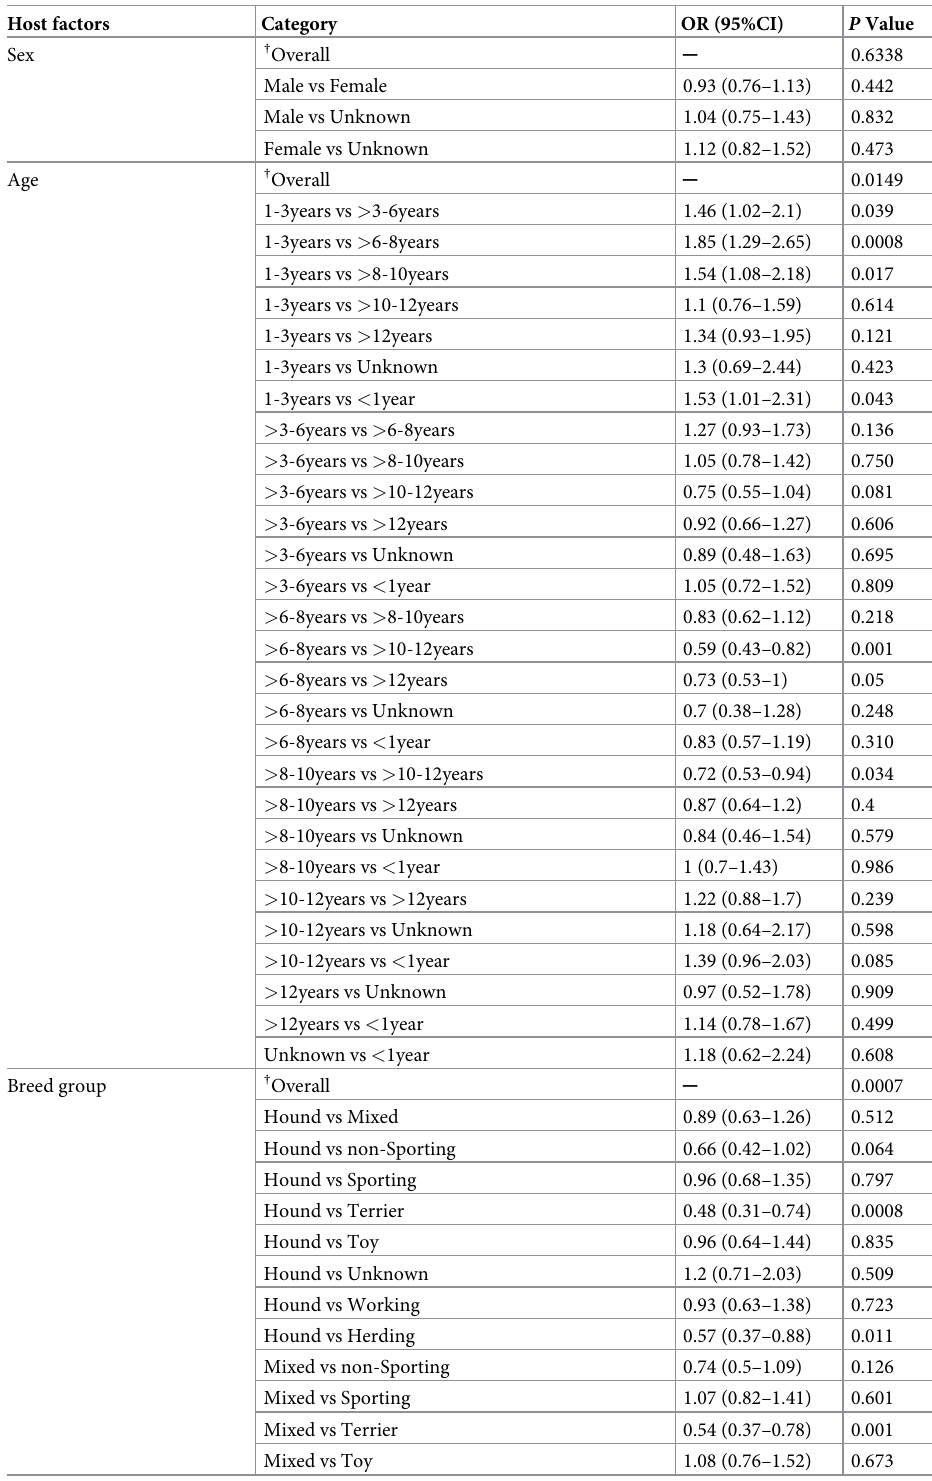
Table 5. Results of univariable logistic regression models assessing the association of host factors with antimicro- bial resistance among Escherichia coli isolated from dog specimens originating from